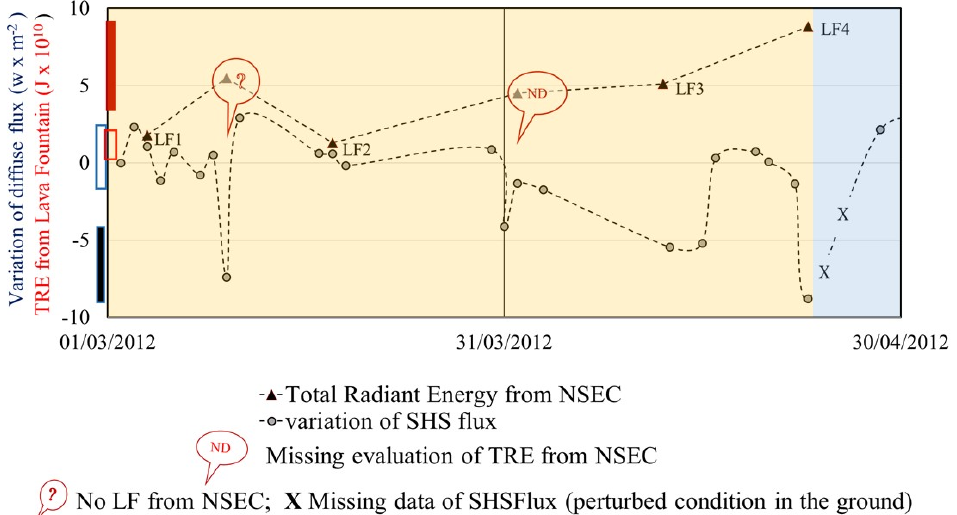
Figure 7. Comparison between the daily variations in SHS Flux values recorded at the BTL station and the total radiant energy (TRE) associated with four lava fountain episodes that occurred on the same days (as evaluated by Bombrun et al. [30]). The daily variations in SHS Flux in the absence of paroxysms are also reported (unlabeled symbols). All data are listed in Table 2. The red open bar on the vertical axis indicates the range of TRE for the minor lava fountains; the blue open bar indicates the range of the heat flux modulation on the NE Rift, showing negligible magmatic influences (background variations in SHS Flux registered at the BTL station); the solid red bar indicates the range of TRE from the major lava fountains; and the solid blue bar indicates the range of daily SHS Flux variations possibly related to the major lava fountains (anomalous variations of SHS Flux registered at the BTL station).